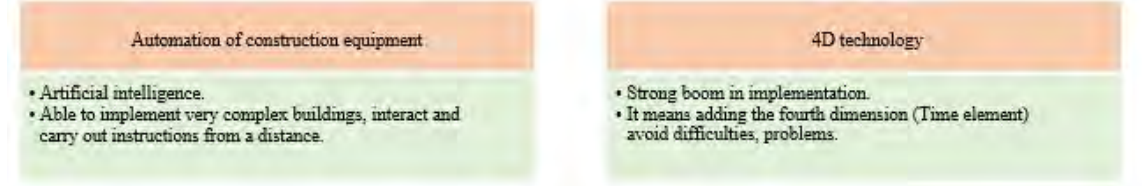
Figure 14. ImplementationMethods in supporting sustainability. Sourcebythe